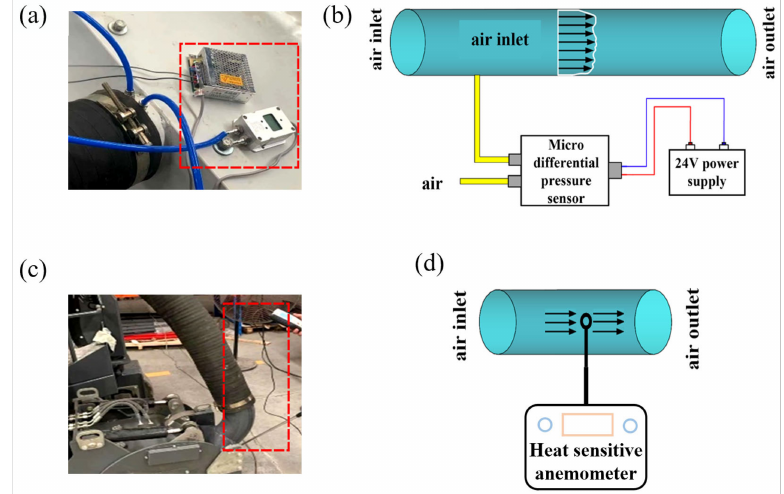
Figure 8. Model accuracy validation test. ( a ) pressure measuring test ( b ) principle of pressure measurement ( c ) wind speed measuring test ( d ) principle of wind speed measurement